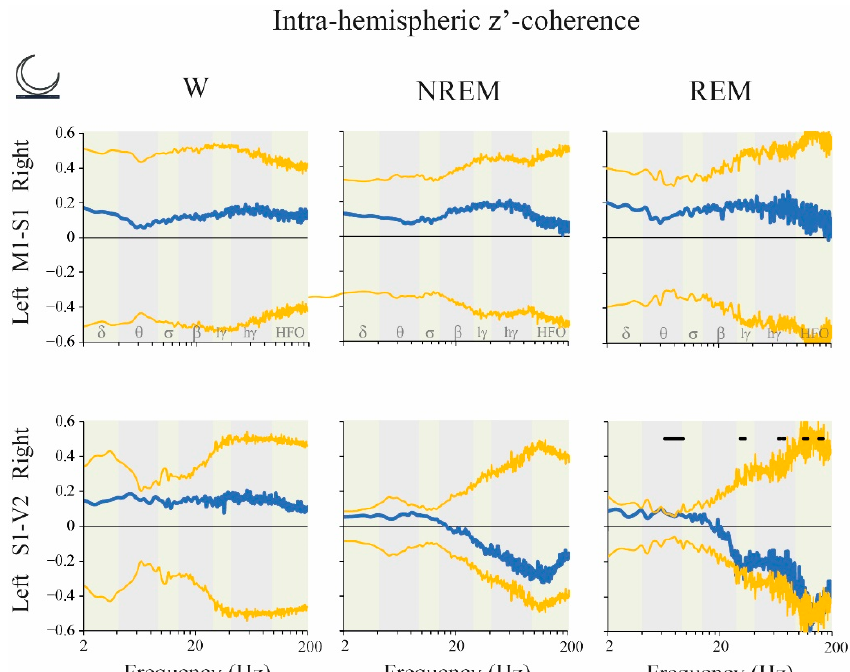
Figure 10. Intra-hemispheric z’-coherence: right vs. left hemispheric difference during the dark phase. The blue traces indicate the mean z’-coherence difference between light and dark phases. The yellow lines represent the standard deviation of the mean with respect to zero. The statistical evaluation was performed by the two-tailed paired t -test with Bonferroni correction for multiple comparisons; no significant differences were observed ( n = 11). We also performed a data-driven approach comparing empirical clusters of frequencies; black lines represent statistical differences in cluster of frequencies, p < 0.05. Coherence was higher in the right hemisphere for the cluster between 6.5 to 9.5 Hz ( p = 0.0009) during REM sleep. In contrast, the clusters between 31 to 34 Hz ( p = 0.022), 68 to 70 ( p = 0.042), 74.5 to